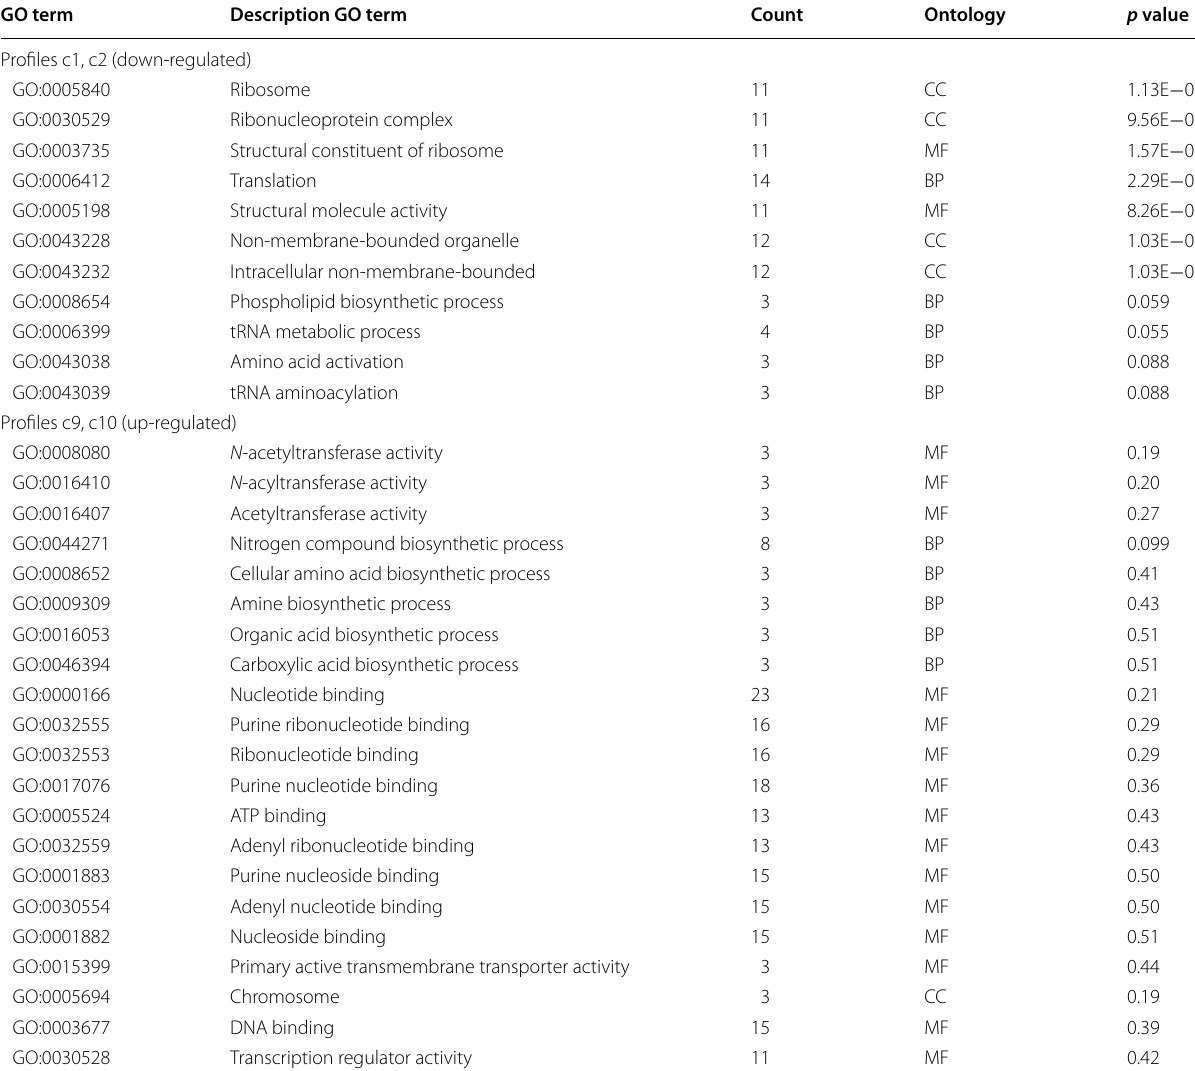
Table 2 Gene ontology (GO) enrichment analysis of four overrepresented clusters c1, c2 and c9, c10 GO term Description GO